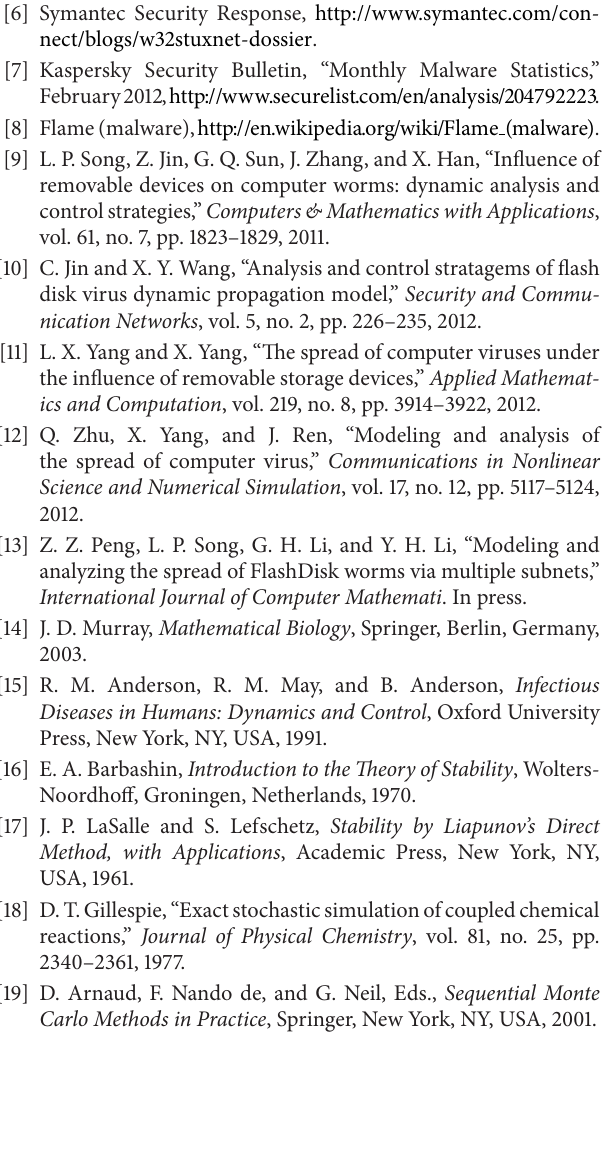
when different values of 𝜆 1 (the radius of neighbour area) are considered, which can guide us in designing effective countermalware